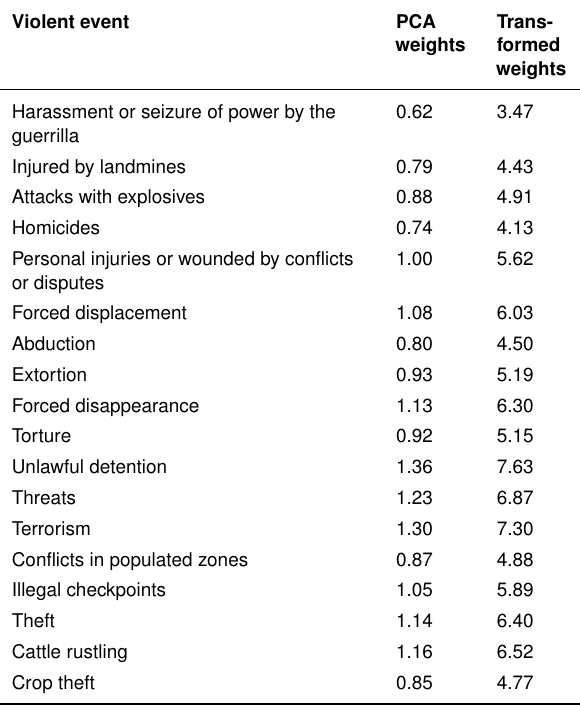
Table 5. Weights associated the HSI* using quantitative variable. Violent event PCA